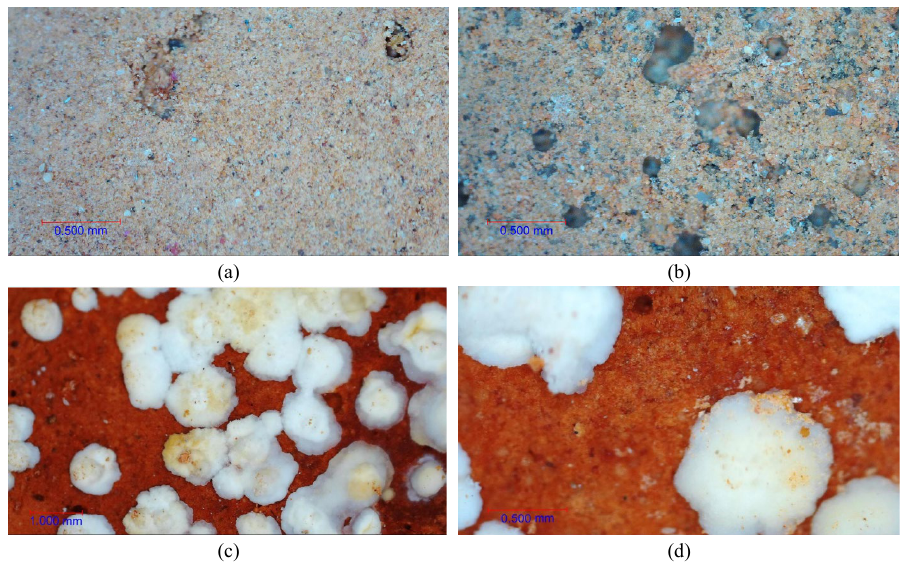
Fig. 6. AAM microstructure at 40× and 120× magnification: a) Calcined clay at 800 ° C with 6 M NaOH activation solution; b) Ground brick precursor activated with 6 M NaOH; c) Ground brick (60 wt.%) and silica gel (40 wt.%) precursor activated with 6 M NaOH at 40x magnification; d) Ground brick (60 wt.%) and silica gel (40 wt.%) precursor activated with 6 M NaOH at 120×